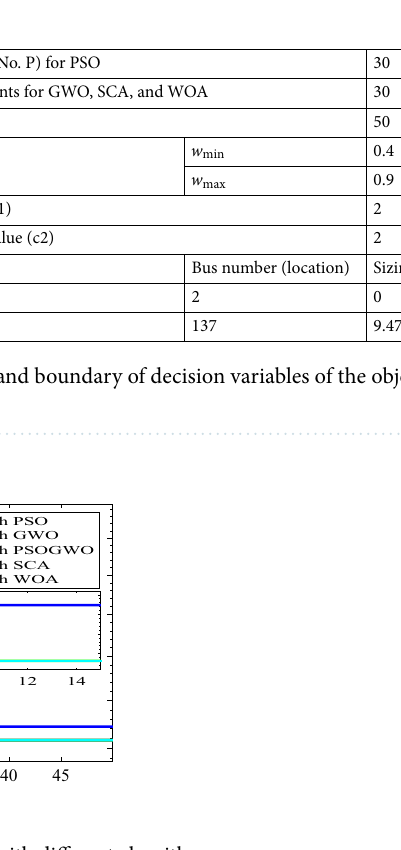
Figure 5. Convergence curve for 1-DG integration with different algorithms.